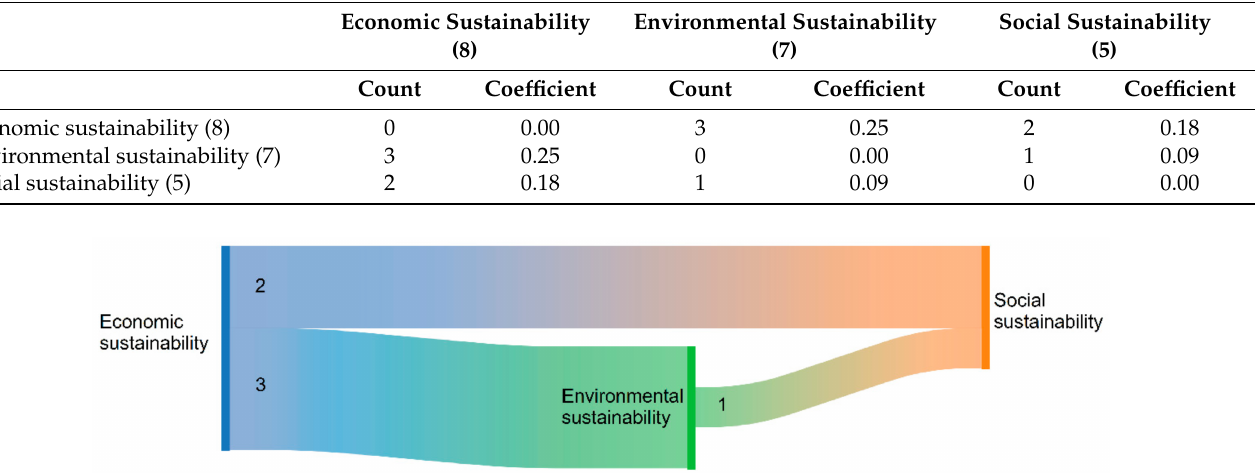
Table 3. Co-occurrences between the findings considered limitations of the sustainability category, from the review of scientific articles on timber buildings.